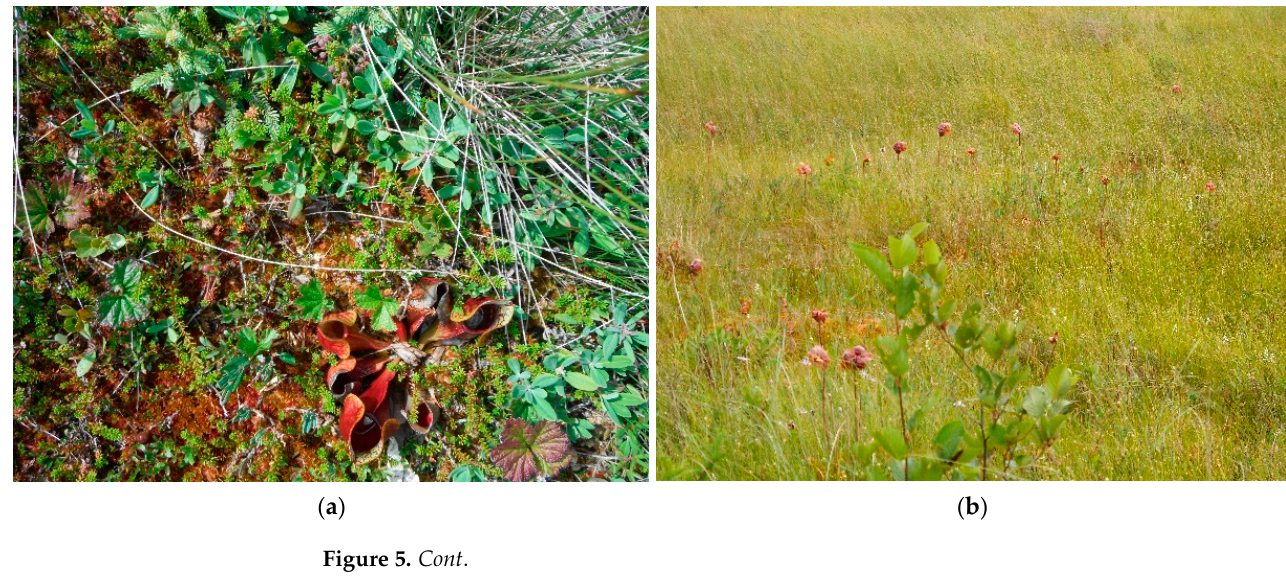
Figure 4. The location of the study area with an overlay of RCM data. A wide variety of wetland classes categorized by the Canadian wetland classification system (CWCS), namely bog, fen, swamp, and marsh are available in the study area. This is an ideal case to investigate the capability of RCM data in combination with Sentinel-2 for wetland classification. For each class, reference polygons were sorted by size and alternatingly assigned to training and validation groups. This alternative assignment ensures that both the training and validation groups have comparable pixel counts for each class (i.e., 50% for training and 50% for validation). A description of the ground truth data used in this study for wetland classification can be found in [26]. Figure 5 demonstrates ground photo examples of these wetland classes.